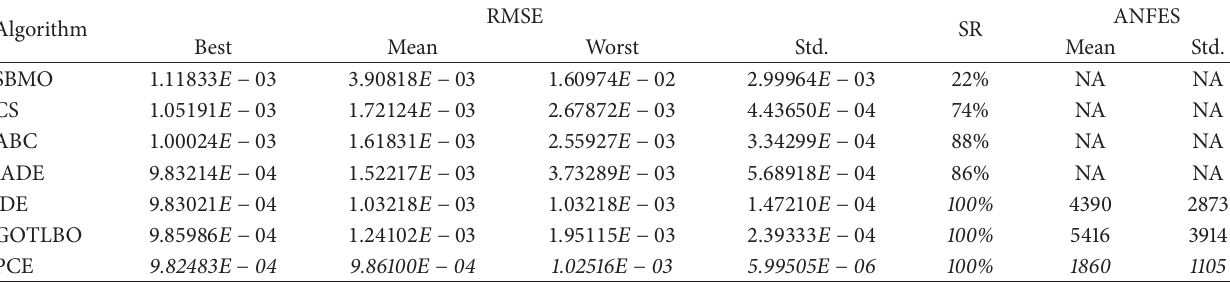
Figure 6: Comparison results from the real data and simulated data obtained by PCE for (a) the single diode model and (b) the double diode model. Table 10: Simulation results for the double diode